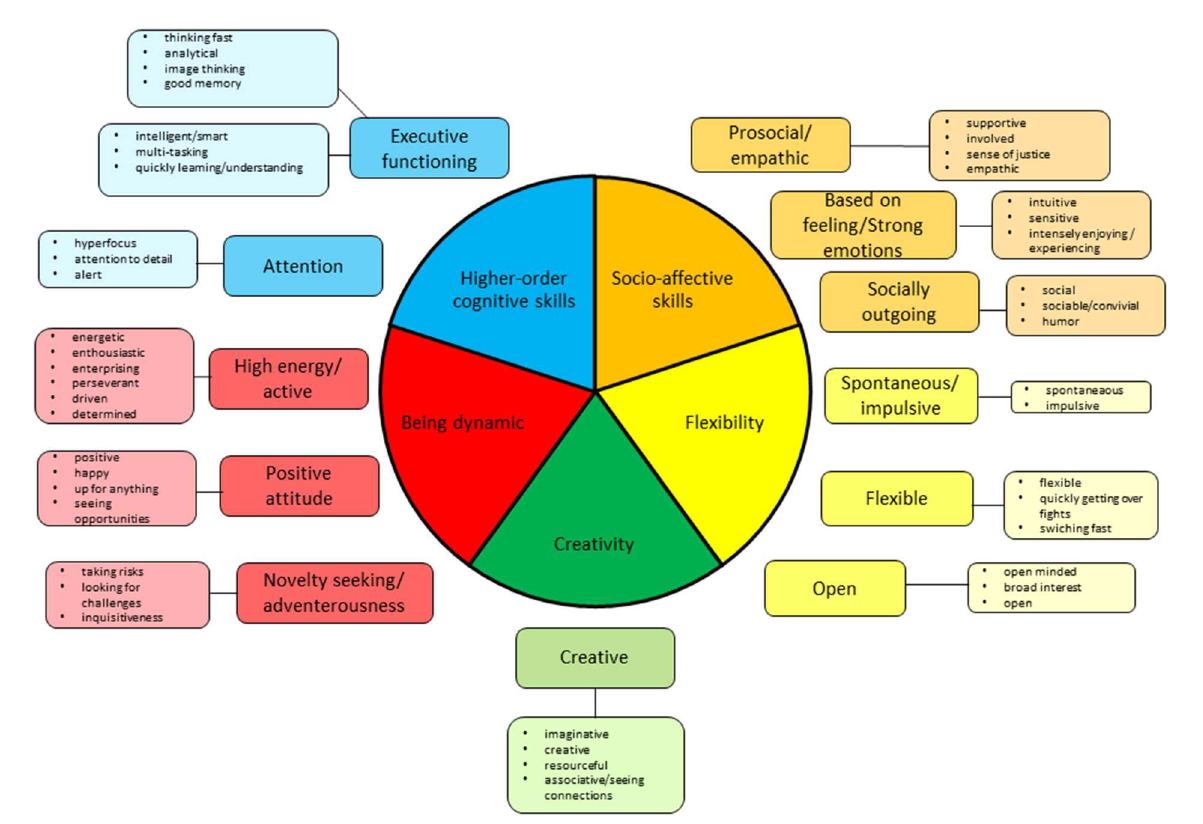
FIGURE2 Overview of the self-reported positive aspects of ADHD grouped into subthemes and